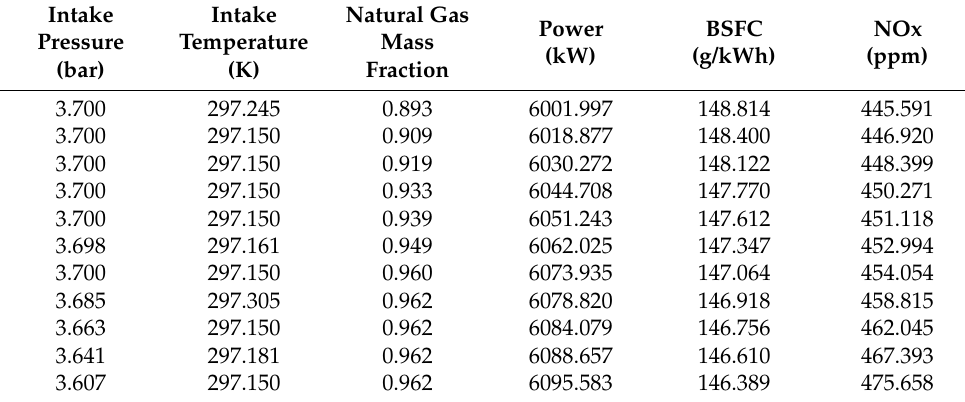
Table 9. Optimal solutions for satisfying